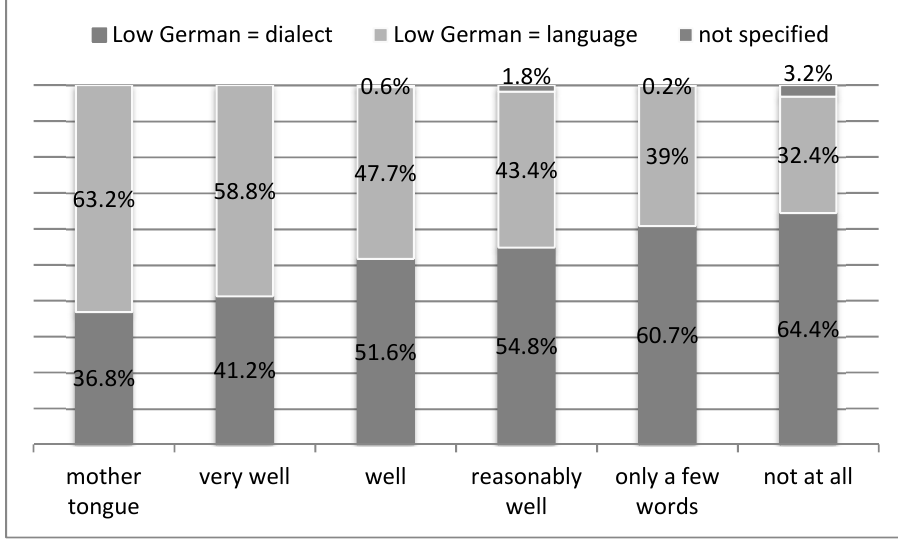
Figure 3. The assessment of Low German’s status by proficiency in Low German (NGS2016).